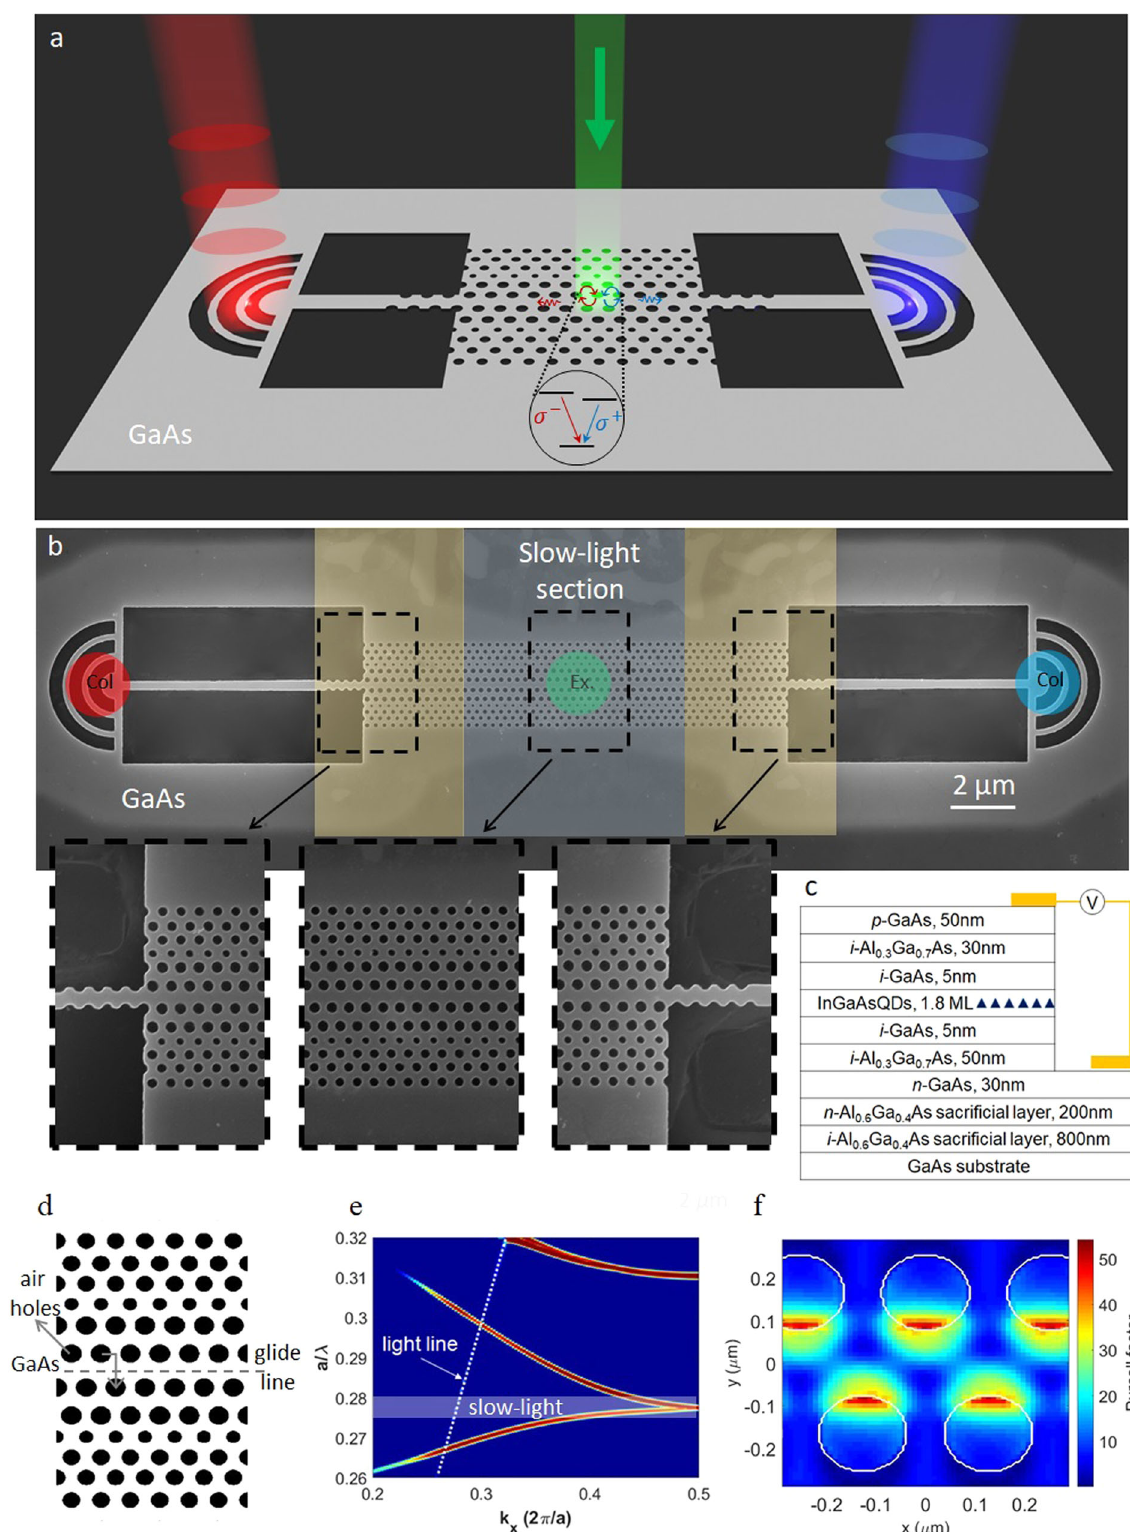
Fig. 1 Chiral nanophotonic waveguide device. a Schematic of the device layout and working principle. b SEM image of the PCW device patterned on a GaAs wafer. c Schematic of the p-i-n GaAs diode structure with embedded InGaAs QDs. d Top-view of the slow-light section of the PCW with an up-down glide-plane symmetry. e Simulated band structure of the PCW. f Spatial pro fi le of the Purcell factor inside the PCW at a frequency around the crossing point of the slow-light